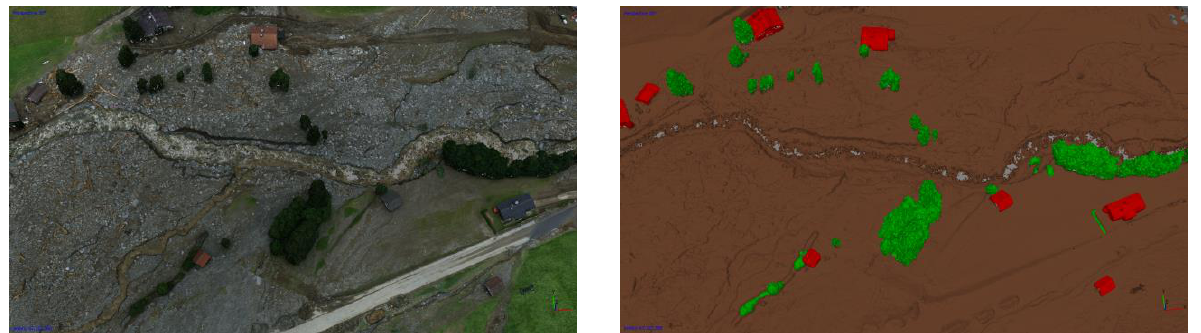
Figure 3. Photogrammetric processing of the valley floor - RGB-coloured DPC (left); classification of DPC into ground (brown), vegetation (green) and buildings (red) (gaps in DPC – grey) (right)